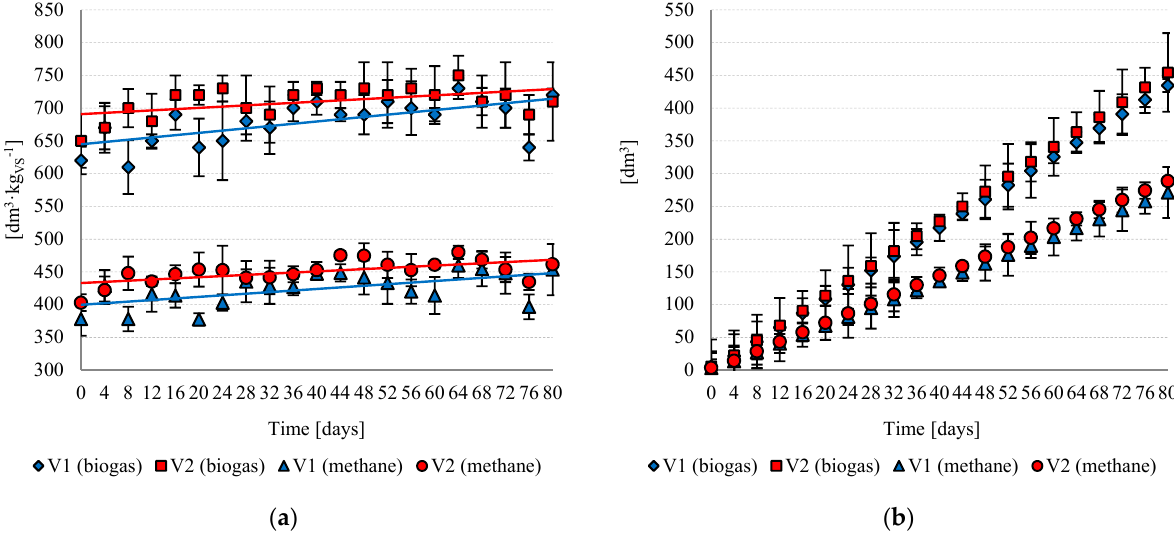
Figure 3. Daily ( a ) and cumulative ( b ) biogas and methane production.